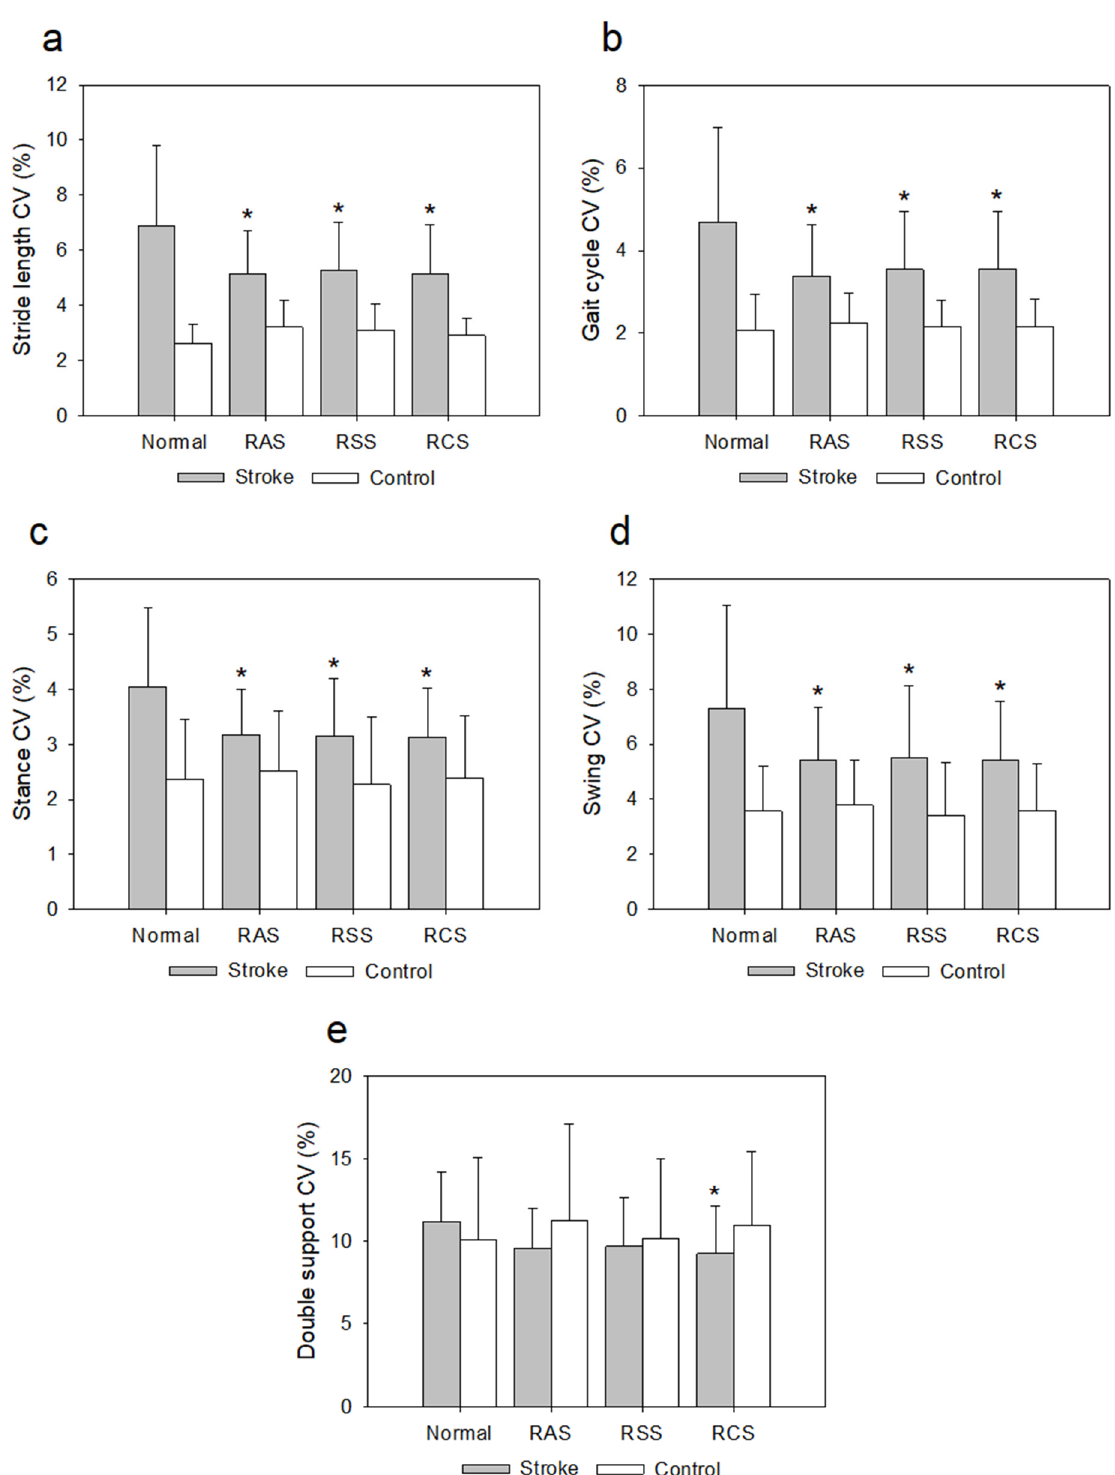
Figure 5. Effects of rhythmic sensory stimulation on gait variability compared to normal walking. Coefficients of variation (CV) of ( a ) stride length; ( b ) gait cycle; ( c ) stance; ( d ) swing; and ( e ) double support. Normal: no stimulation; RAS: rhythmic auditory stimulation; RSS: rhythmic somatosensory stimulation; RCS: rhythmic combined stimulation (RAS + RSS); * indicates significant difference compared to normal condition ( p < 0.008).